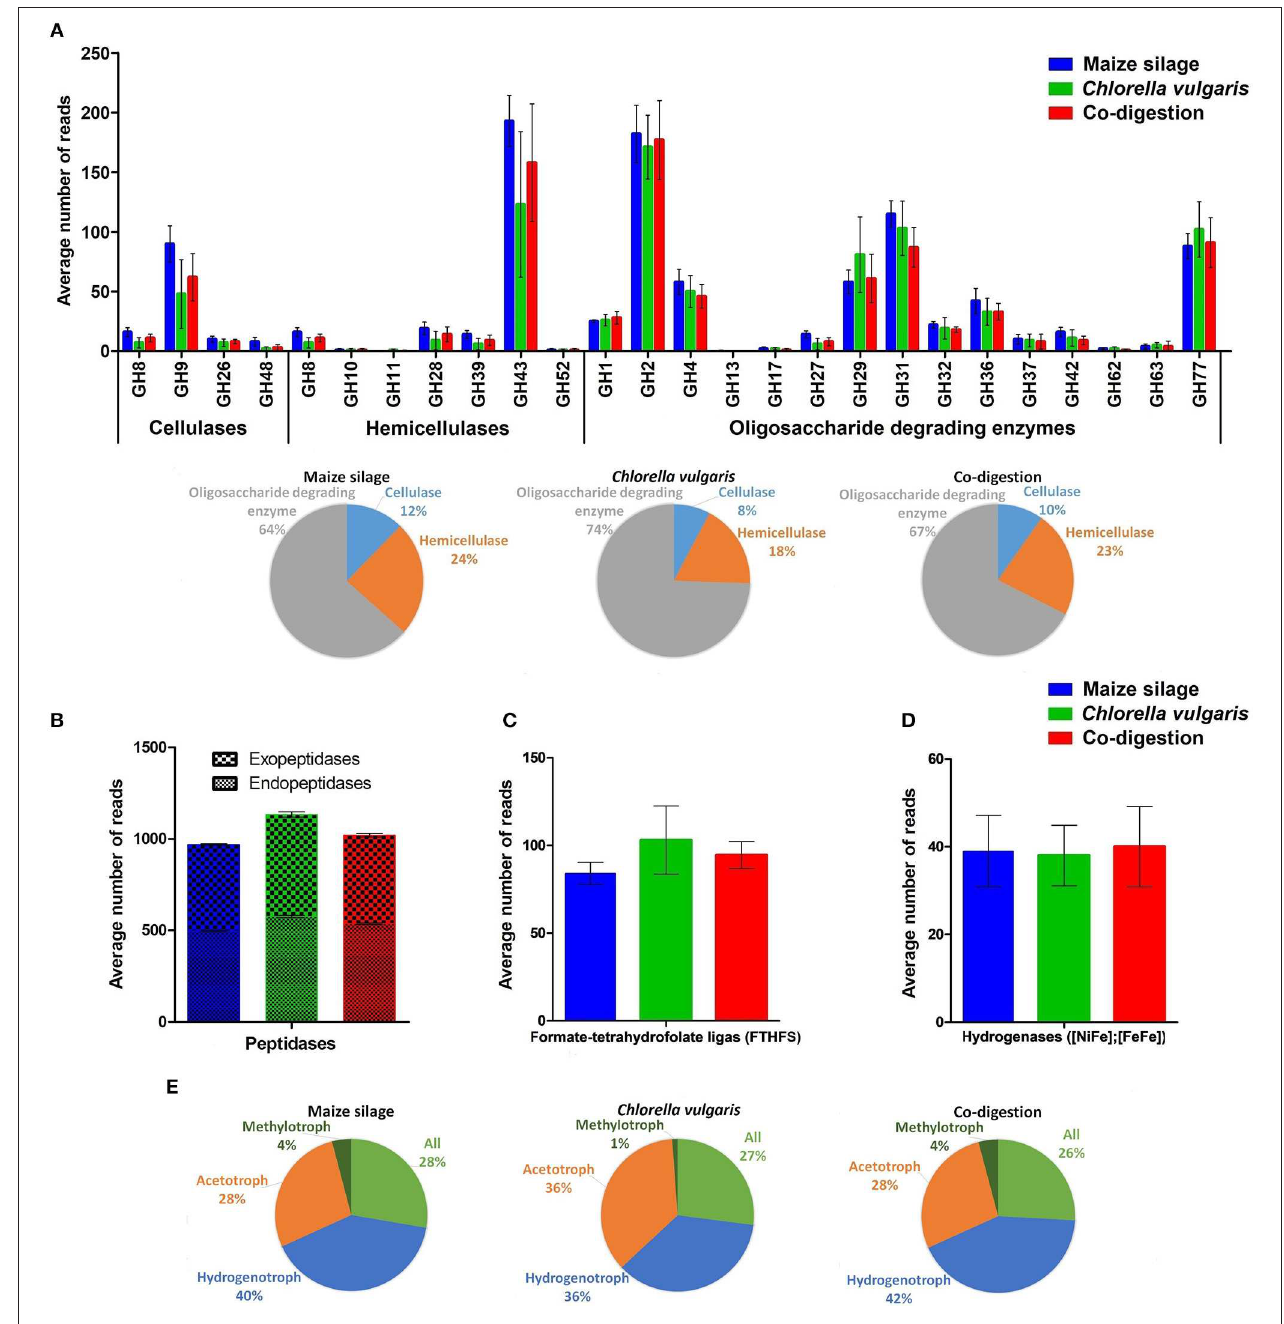
FIGURE 7 | Functional profiles. (A) Identified carbohydrate active enzymes (CAZy) categorized by activity, and the proportions of CAZy in the various ADs. (B–D) The distribution of peptidases, formate tetrahydrofolate ligase (FTHFS), and hydrogenases, respectively. (E) Proportions of methanogenic enzymes categorized by methanogenic pathways. Each graph indicates the average of 6 metagenomes belonging to the indicated